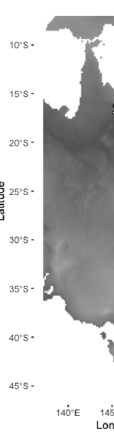
Figure 1. Locations of Queensland fruit fly (Q-fly) specimens examined for morphological variation, mapped over the minimum temperature of the coldest month (Bio06 [1]).